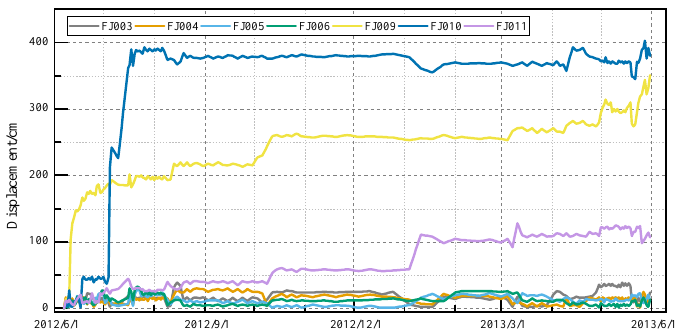
Figure 3. Displacement change curve of monitoring points of the Huanglianshu landslide.